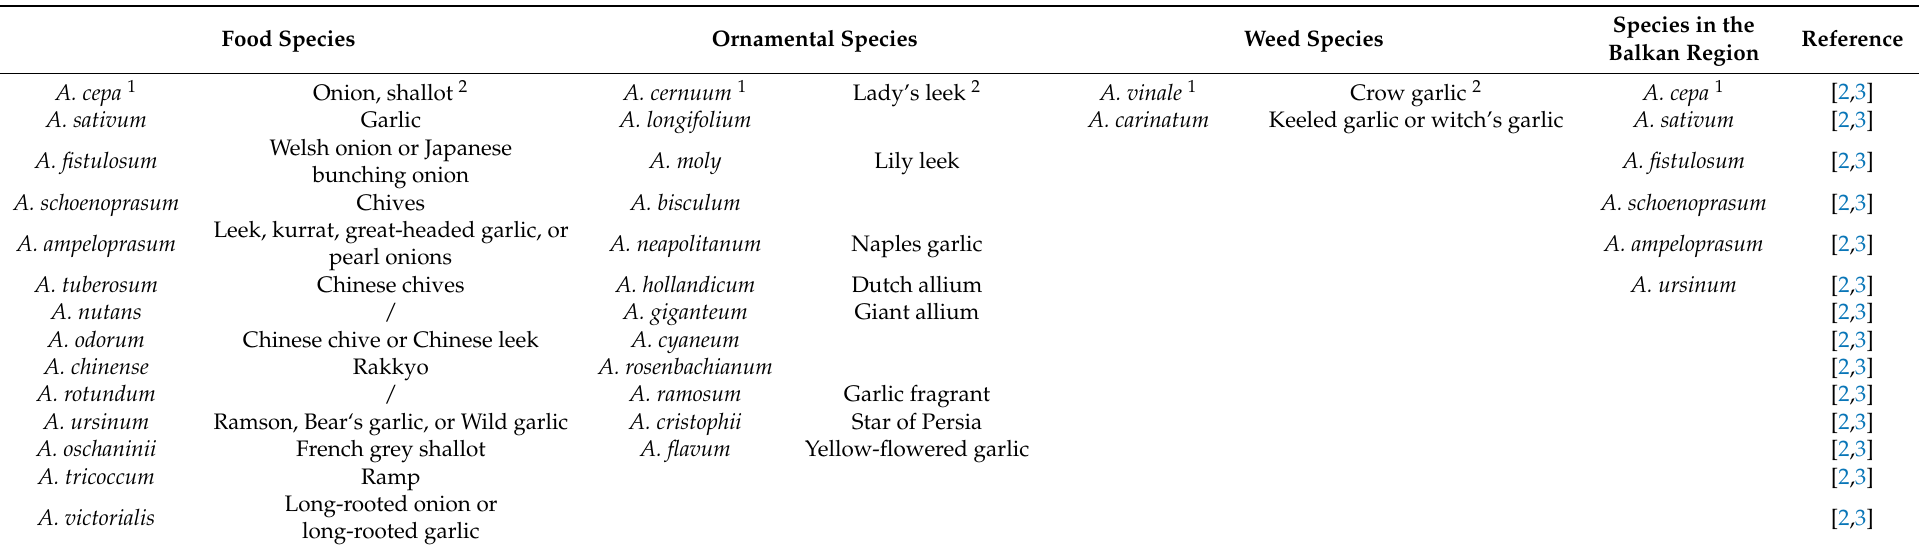
Table 1. Most common Allium species, and species characteristic for the Balkan region. Food